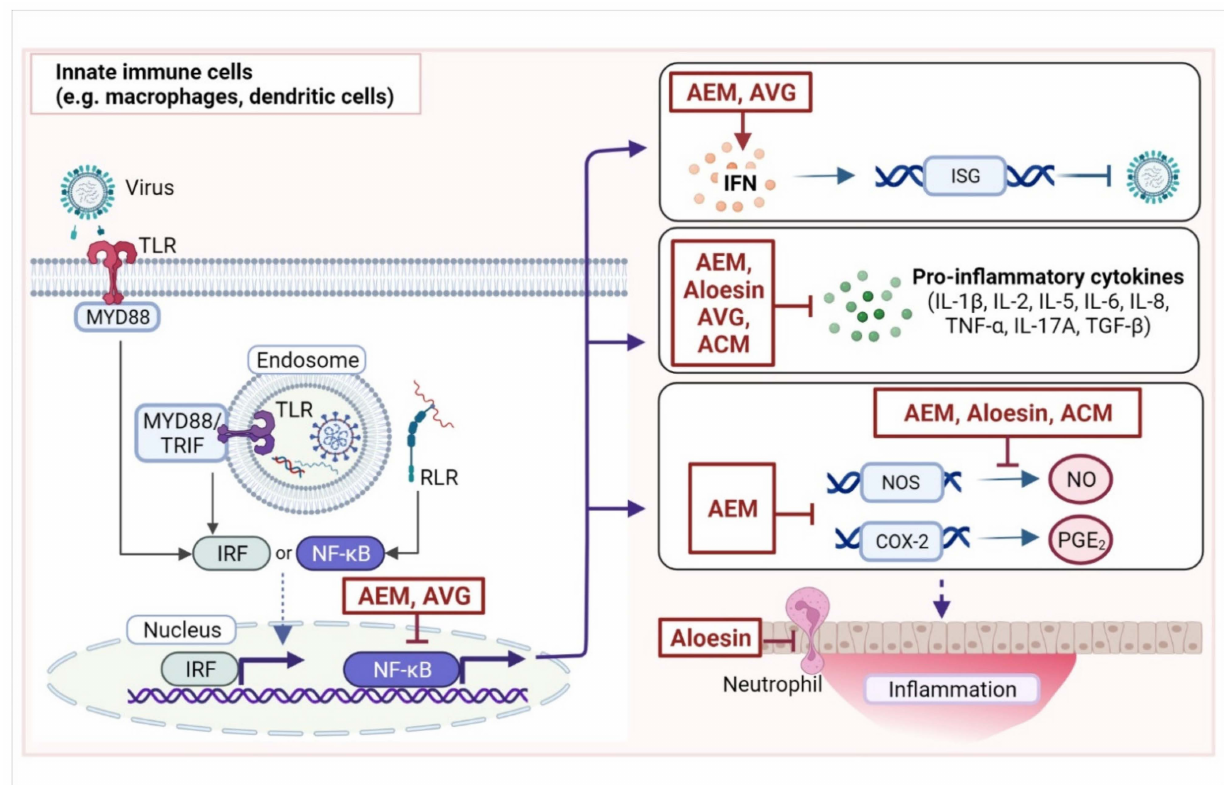
Figure 2. Targets of compounds from Aloe , especially Aloe vera , in the innate immune response. Innate immune cells, including macrophages and dendritic cells, recognize viral infection through pattern recognition receptors such as the Toll-like receptors (TLR3, TLR7, TLR8, and TLR9) or RIG- I-like receptors (RLR). Upon signal stimulation, TLRs recruit adaptor proteins, such as myeloid differentiation primary response 88 (MYD88) and TIR domain-containing adapter molecule 1 (TRIF). This initiates signaling cascades that activate transcription factors, mainly interferon regulatory factors (IRFs) and nuclear factor kappa B (NF- κ B). IRFs are typically involved in the production of interferons (IFNs) that, in turn, stimulate the expression of products of IFN-stimulating genes (ISGs) that have antiviral functions. Meanwhile, NF- κ B is a master regulator of the immune response and activates the transcription of several proteins involved in the immune response including ISGs and cytokines, such as interleukins (IL), tumor necrosis factor α (TNF- α ), and transforming growth factor β (TGF- β ). NF- κ B also activates the transcription of the inducible nitric oxide synthase (NOS)-2 gene, which catalyzes the production of nitric oxide (NO) that regulates local inflammation. Moreover, NF- κ B activates the transcription of cyclooxygenase-2 (COX-2), which converts arachidonic acid to prostaglandin E 2 (PGE 2 ), which induces inflammation. Tissue inflammation recruits other cells, such as granulocytic neutrophils, to the site of infection. Shown here are some of the reported targets of compounds from Aloe spp., especially A. vera , such as aloe emodin (AEM), A. vera gel (AVG), acemannan (ACM), and aloesin in the innate immune response. While in most cases, A. vera compounds inhibit pro-inflammatory responses, they may also promote certain responses, such as IFN production. (Image was created with BioRender.com, accessed on 27 April